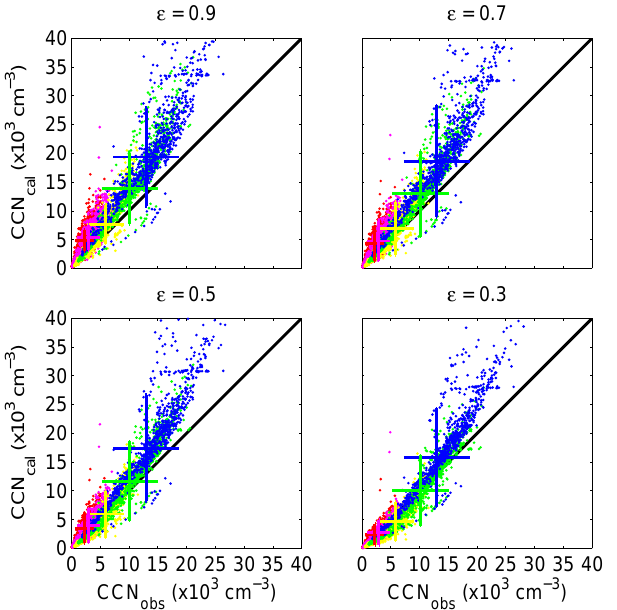
Fig. 3. Comparison between the calculated and observed CCN num- ber concentration for 4 different mass fractions of ammonium sul- fate ( ε) at different supersaturations. The insoluble material is as- sumed to be externally mixed with ammonium sulfate. Colour cod- ing of supersaturations and representation of mean and standard de- viation is as in Fig. 1.